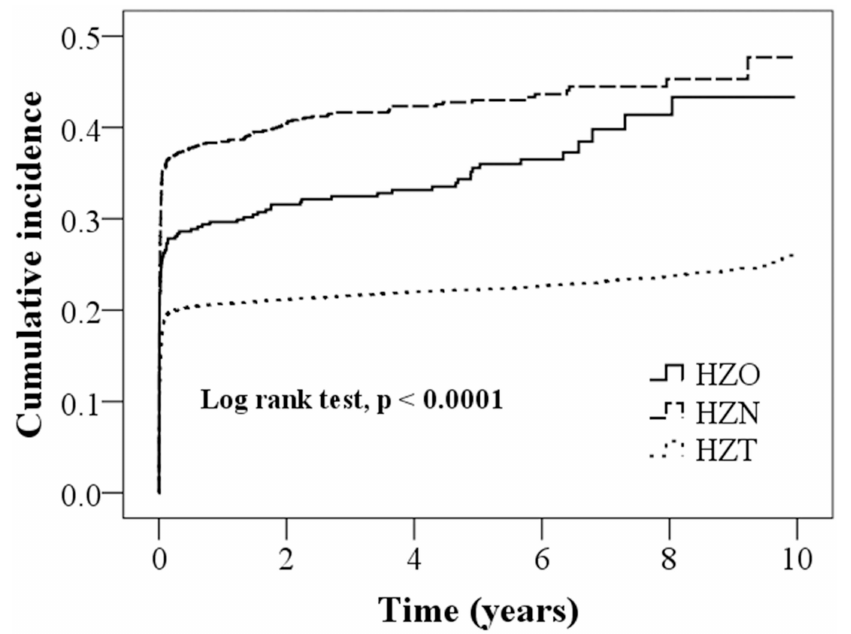
Fig 1. Overall cumulative risks of complications in the HZO, HZN, and HZT cohorts.